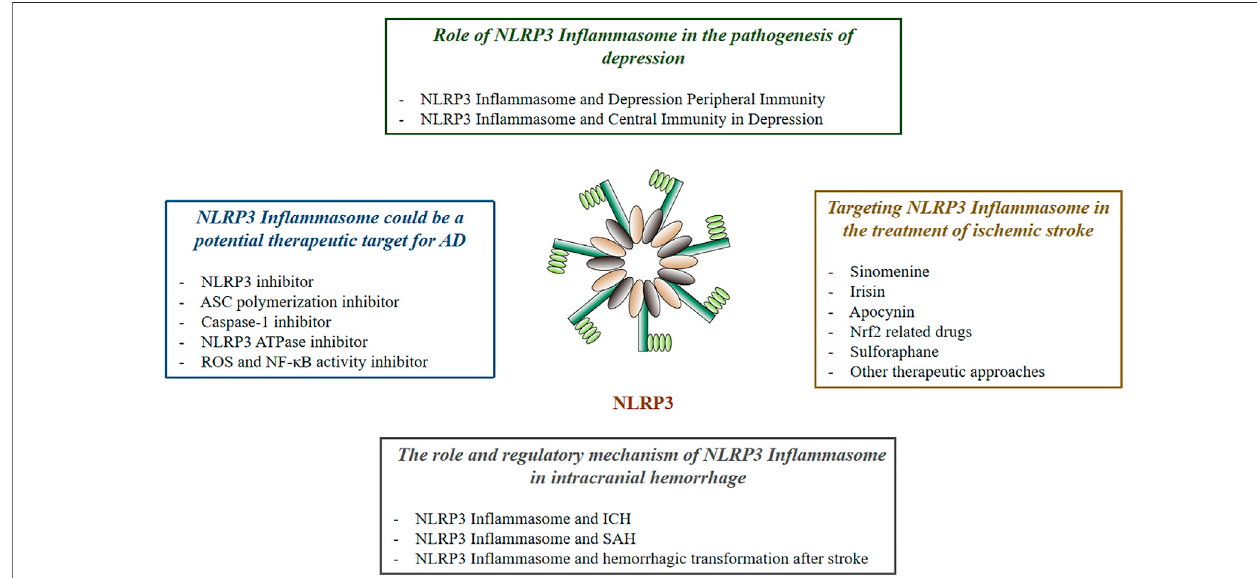
FIGURE 1 | The Effect of NLRP3 in Neurological Diseases.